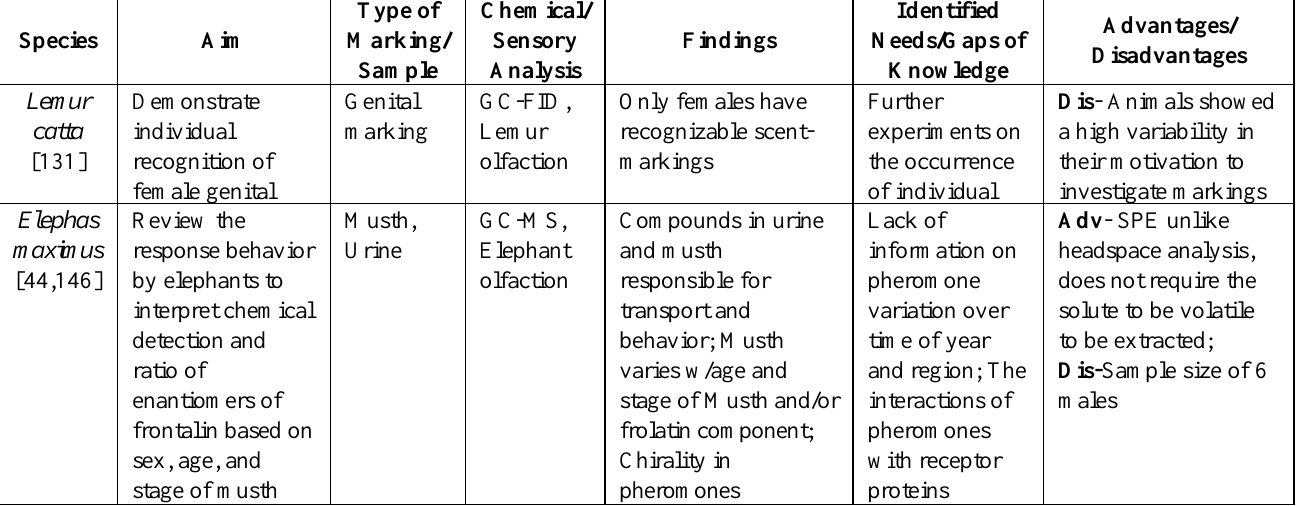
Table 2. Summary of simultaneous sensory and chemical analysis of scent-markings from endangered large